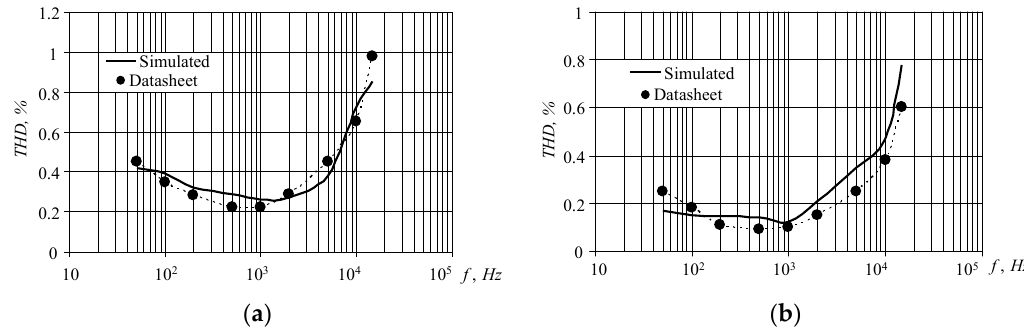
Figure 11. Simulated results and datasheet parameters for non-linear distortion versus frequency of the input signal: ( a ) at a load resistance equal to 2 Ω; ( b ) at a load resistance equal to 4 Ω.